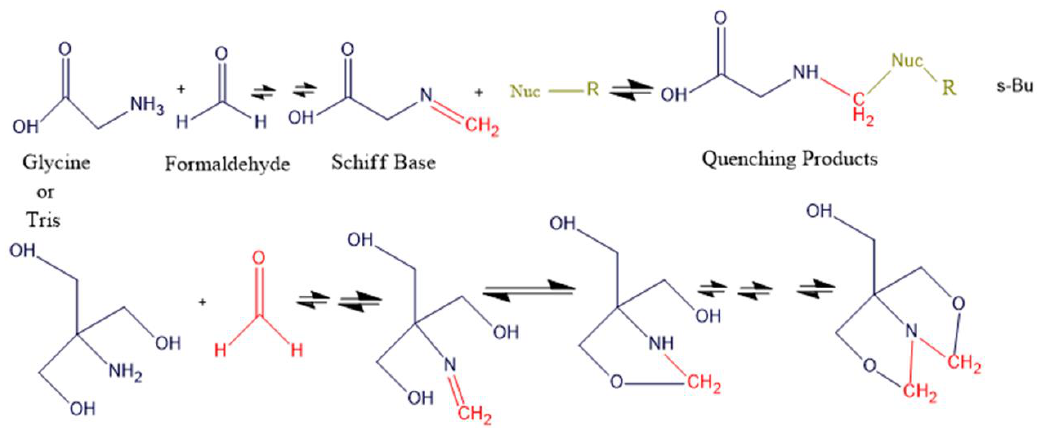
Figure 4. Glycine and Tris quenching reactions of formaldehyde: The chemical reactions are like those shown in Figure 3 above with the amino group of glycine or Tris serving as the principal nucleophile. The Schiff base formed from glycine is not necessary to react with a second nucleophile, but regardless, the crosslinking between protein–DNA will be quenched. The Tris molecule has another available nucleophile (hydroxyl group) that creates stable intramolecular penta-membered rings. Tris can also react with two molecules of formaldehyde, resulting in the last product shown. The tendency of Tris forming some stable intramolecular products allows it to search for formaldehyde from other molecules and thus enable crosslink reversal. Here, mint green color represents DNA/protein.